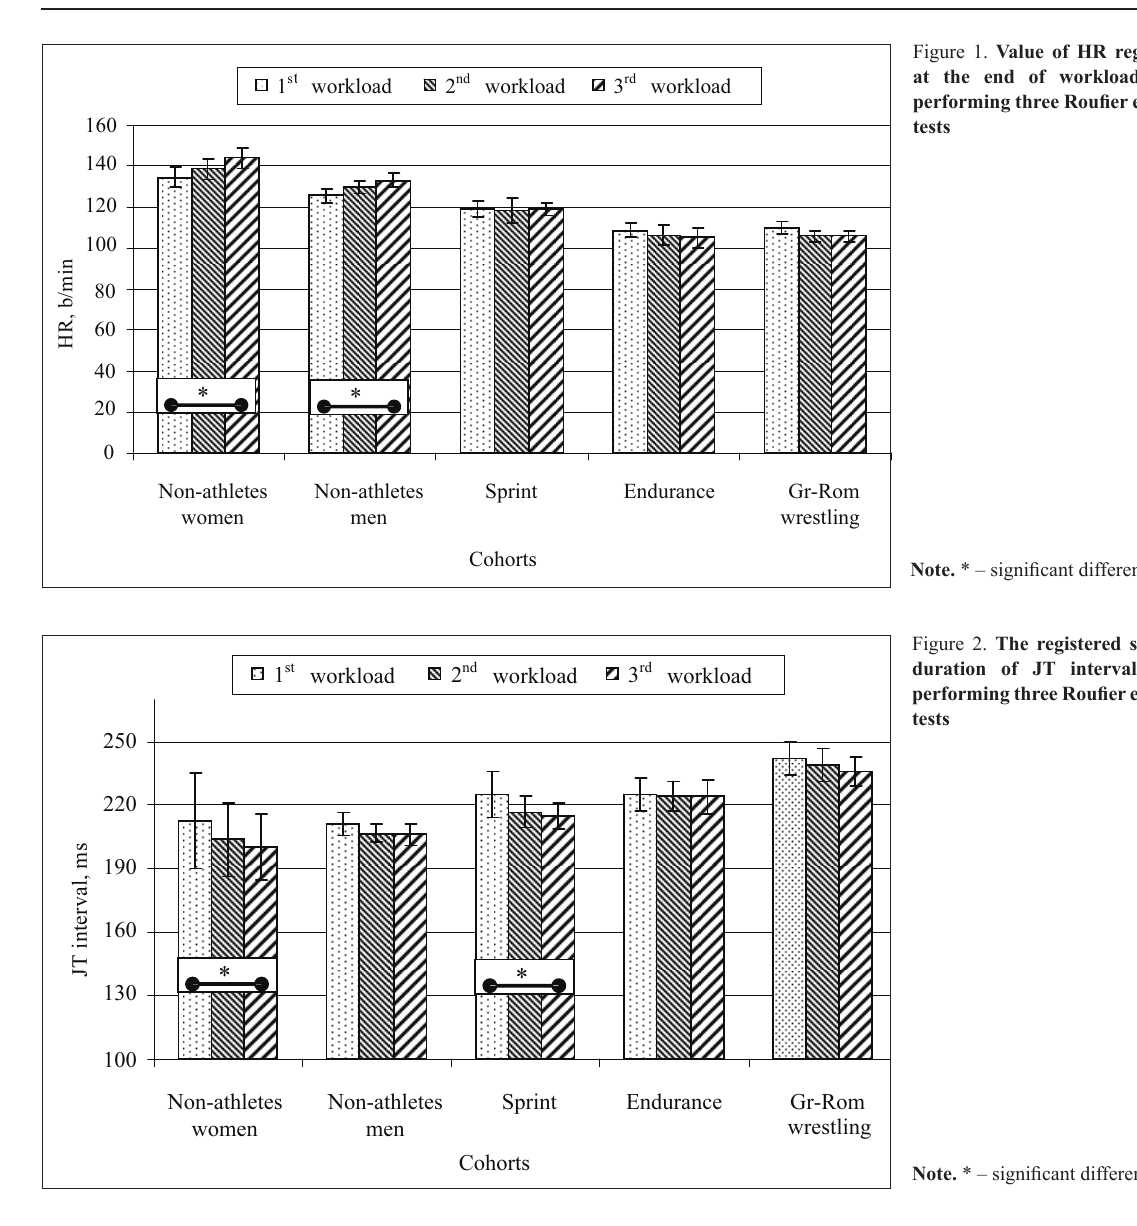
Figure 2. The registered shortest duration of JT interval while performing three